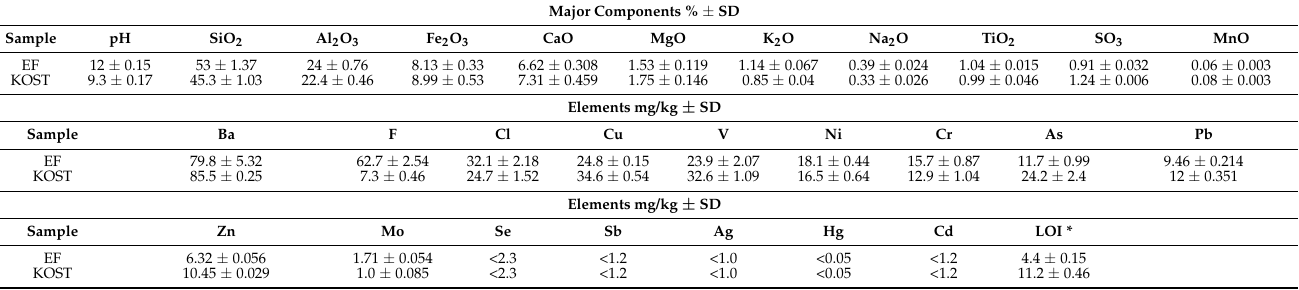
Table 2. Mineral and chemical analysis of fly ash samples EF and